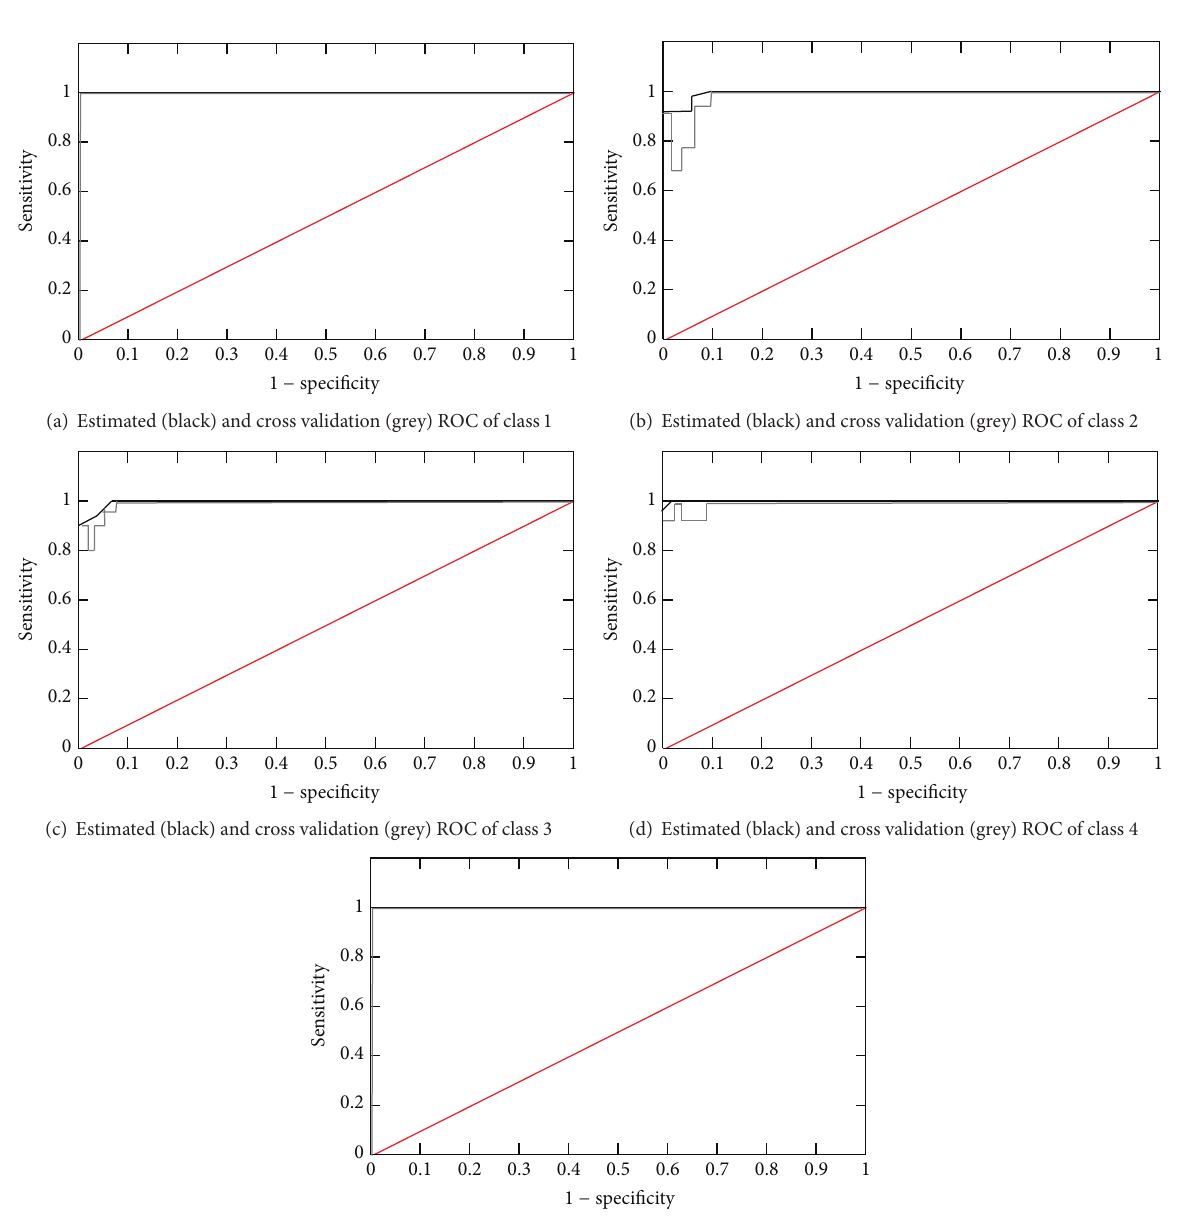
Figure 9: ROC curves of SVM classification model of SEM image samples of the composites in five different aging periods.